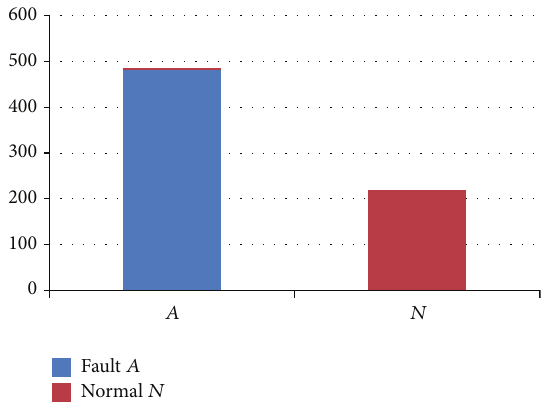
Figure 8: The diagnosis results considering the related parameters.